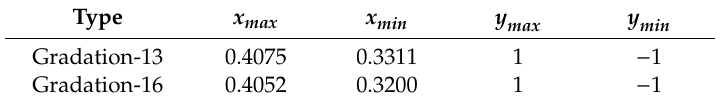
Table 11. The porosity normalization parameters for Gradation-13 and Gradation-16. Type